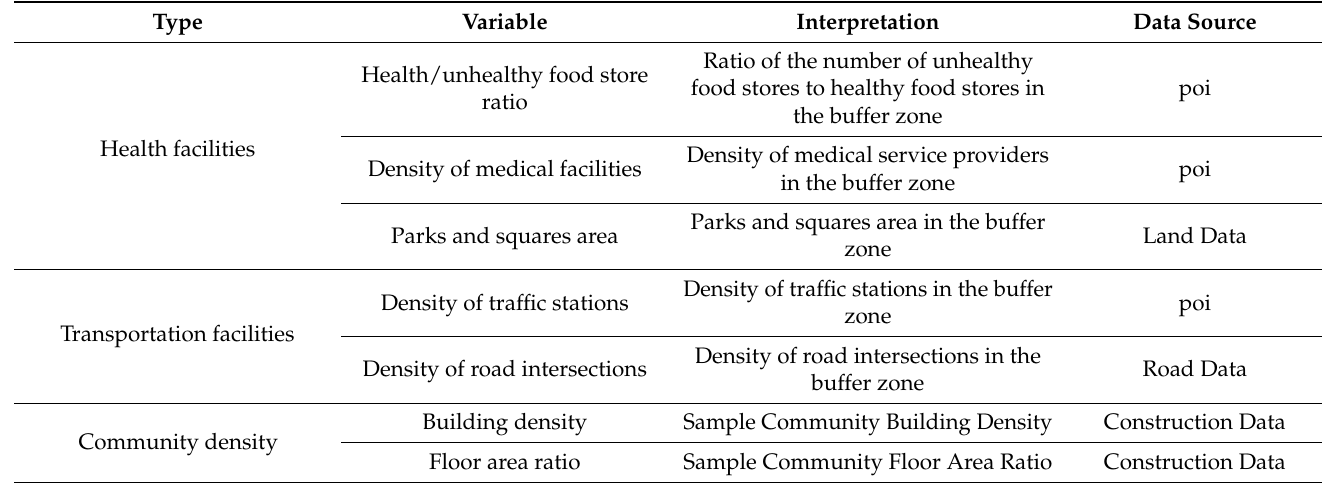
Table 1. Source of Table 1. Source of Variables.